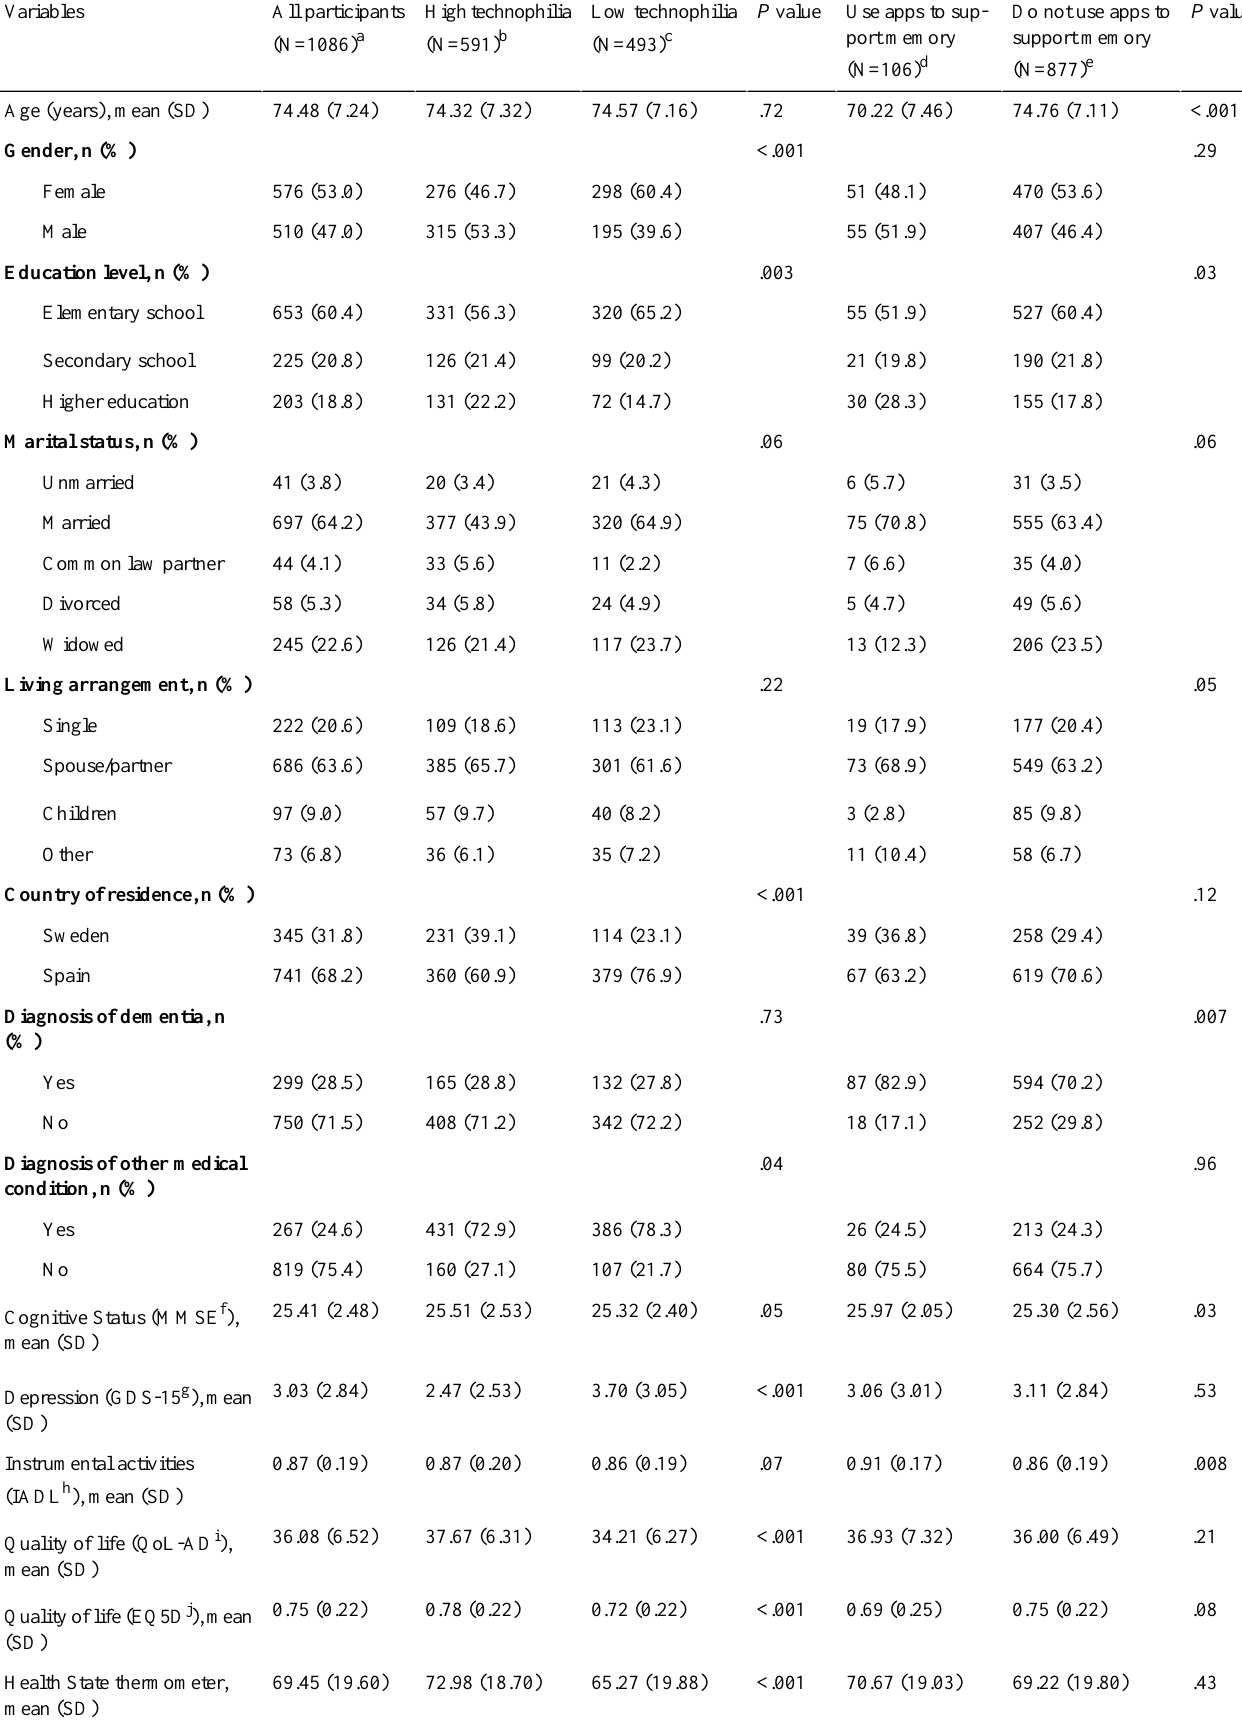
Table 1. Characteristics of participants with dementia or mild cognitive impairment.